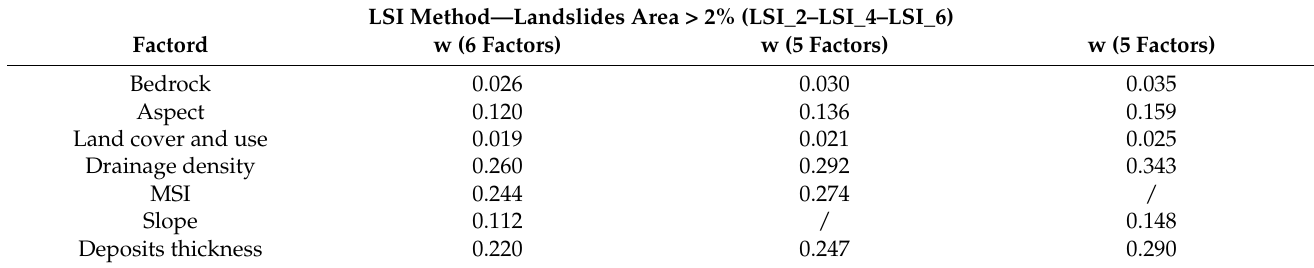
Table A4. Factors’ weight for the models LSI_2–LSI_4–LSI_6.